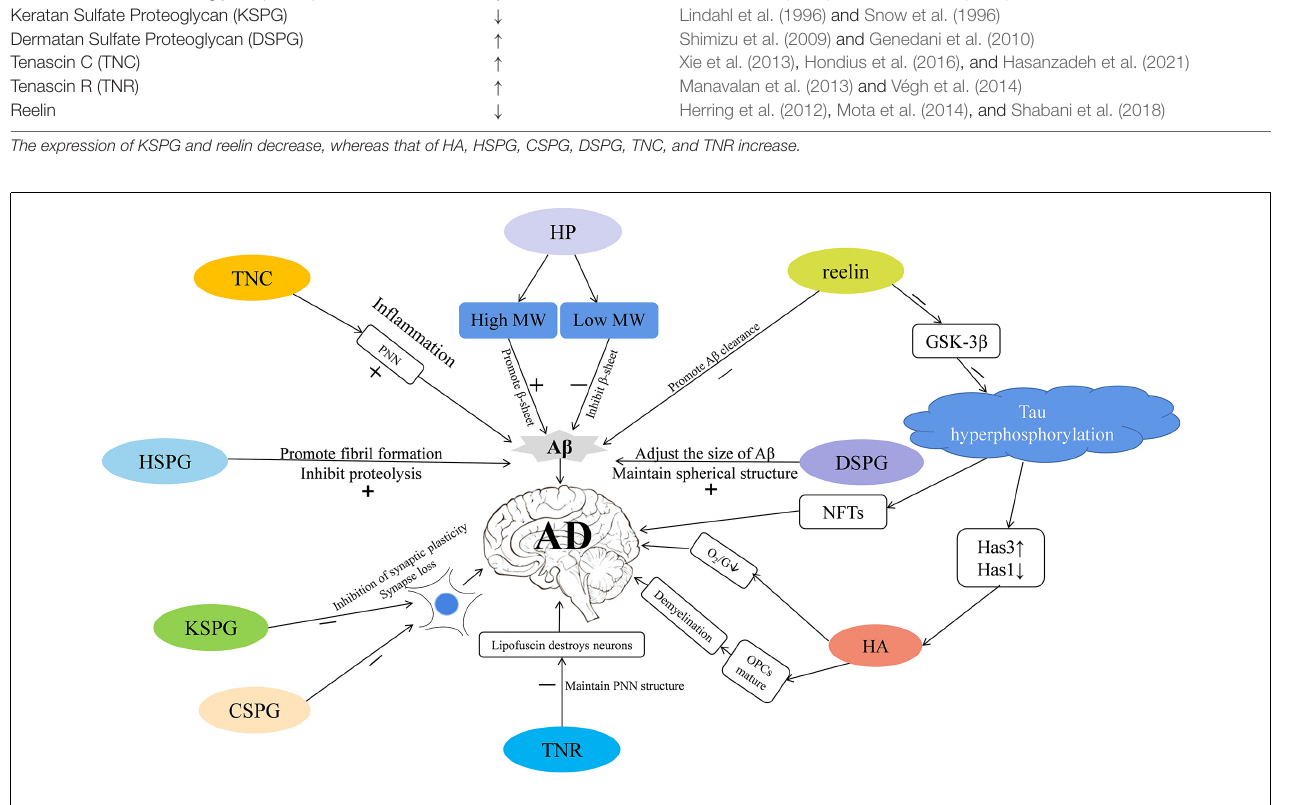
FIGURE 1 | The extracellular matrix (ECM) participates in the progression of Alzheimer’s disease (AD) via different mechanisms. Tenascin-C (TNC) is increased in AD—it increases the stability of perineuronal nets (PNNs) to reduce the clearance of amyloid- β (A β ), and participates in inflammatory pathways that leads to the occurrence of AD. PNNs also wrap around neurons and protect them from the neurotoxic effects of A β . Heparin (HP) is increased in AD—high molecular-weight (MW) HP promotes the formation of β -sheet secondary structure, and low molecular-weight (MW) HP inhibits it, which in turn affects the production of A β . Heparin sulfate proteoglycans (HSPGs) are increased in AD; they promote the formation of A β fibrils, inhibit amyloid hydrolysis, and promote the production of A β . Dermatan sulfate proteoglycans (DSPGs) are increased in AD—they may modulate the size of A β plaques, maintain the spherical structure of A β , thereby regulating the occurrence of AD. Reelin is decreased in AD—it can promote the clearance of A β , and inhibit the expression of GSK-3 β that phosphorylates the Tau protein and promotes neurofibrillary tangle (NFT) formation, thus mediating the occurrence of AD. Tau hyperphosphorylation reduces hyaluronan synthase 1 (Has1), increases hyaluronan synthase 3 (Has3), and up-regulates short-chain Hyaluronic acid (HA). HA is increased in AD; it inhibits the maturation of OPCs, causes demyelination, reduces the supply of brain oxygen and glucose (O2/G), and may promote the occurrence of AD. TENASCIN-R (TNR) is increased in AD; it increases PNNs stability and may prevent lipofuscin from destroying neurons. Keratan sulfate proteoglycan (KSPG) is decreased in AD and chondroitin sulfate proteoglycan (CSPG) is increased; both these macromolecules may inhibit synaptic plasticity, cause synapse loss, and promote pathological damage in